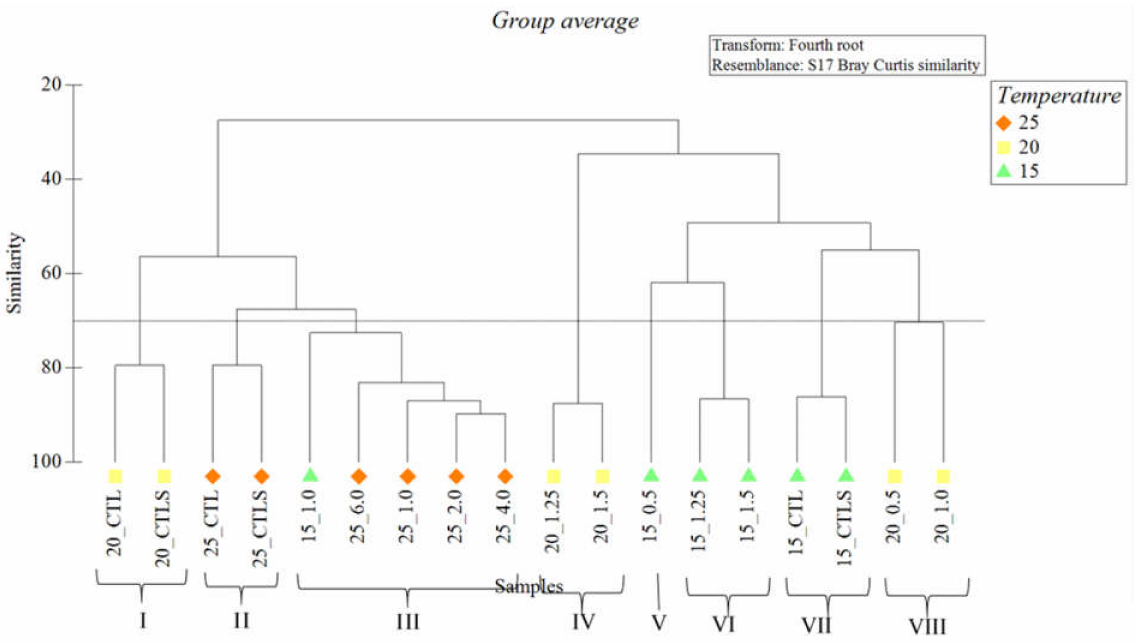
Figure 3. Cladogram (cluster analysis) grouping the diatom treatments related with the FA contents after exposure to oxyfluorfen at 15 ◦ C, 20 ◦ C, and 25 ◦ C, respectively.